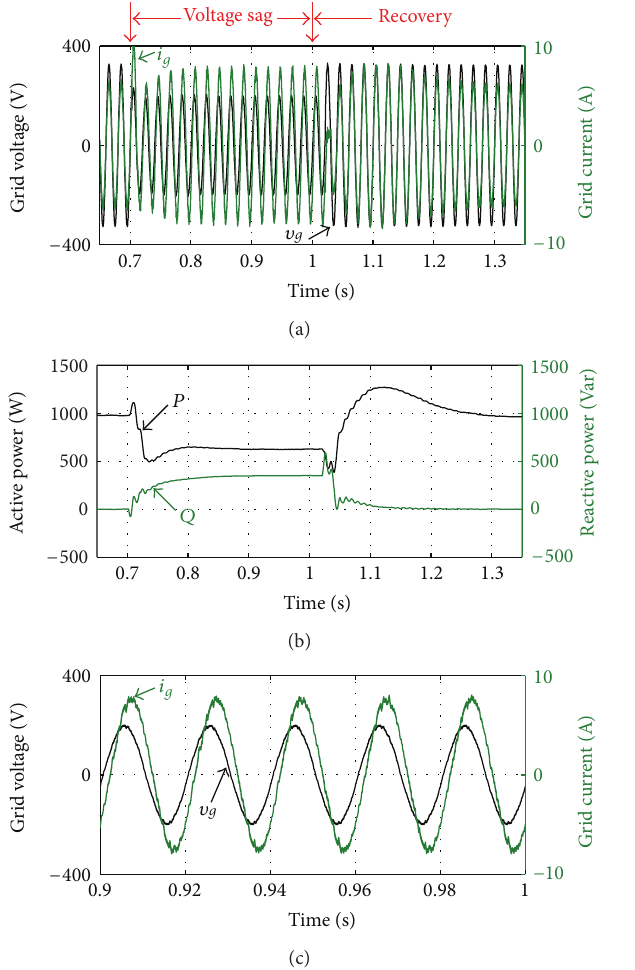
Figure 12: Simulation results for a single-phase PV system under grid fault: (a) grid voltage and current; (b) active and reactive power; (c) grid voltage and current during LVRT.